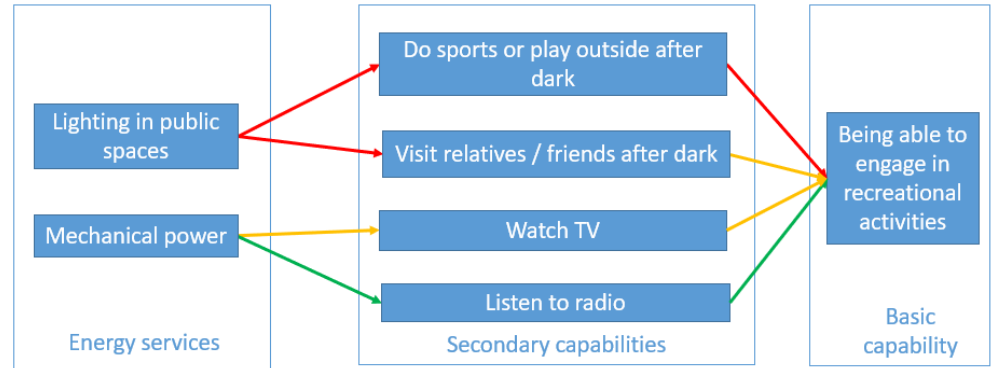
Figure 9. Relationships between energy services, secondary capabilities and ability to engage in recreation.